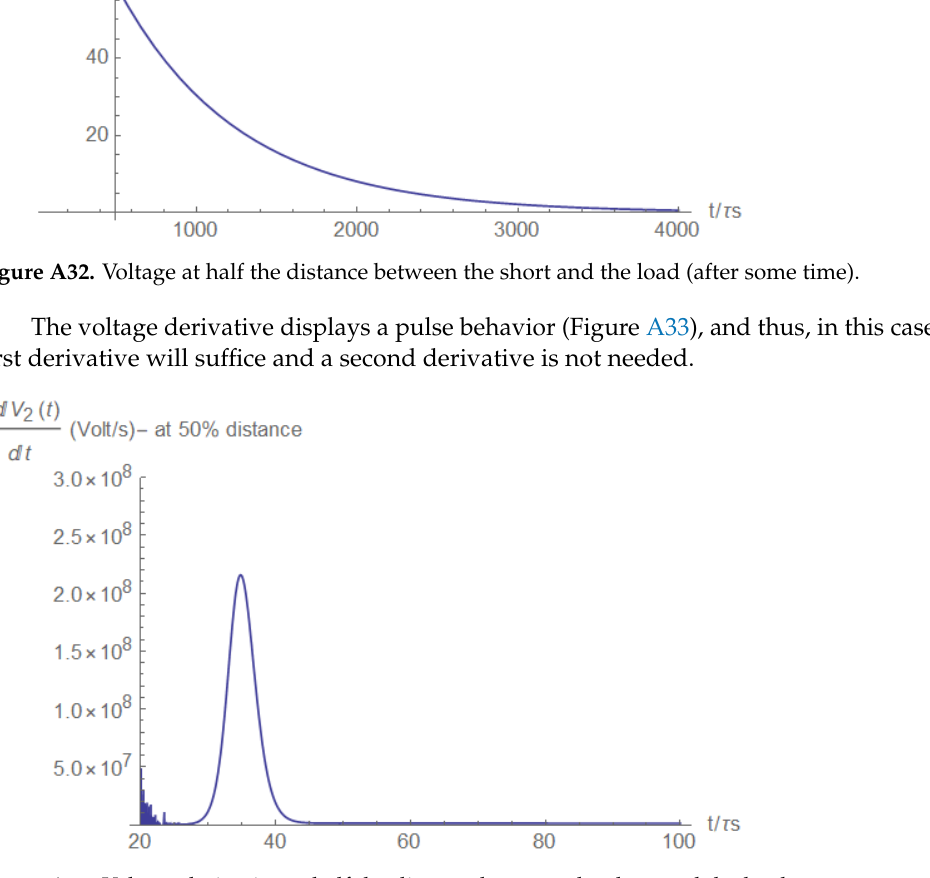
Figure A33. Voltage derivative at half the distance between the short and the